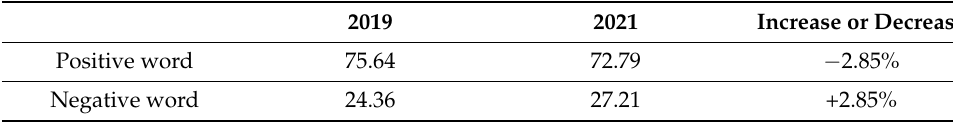
Table 9. Sentiment word frequency of food delivery.